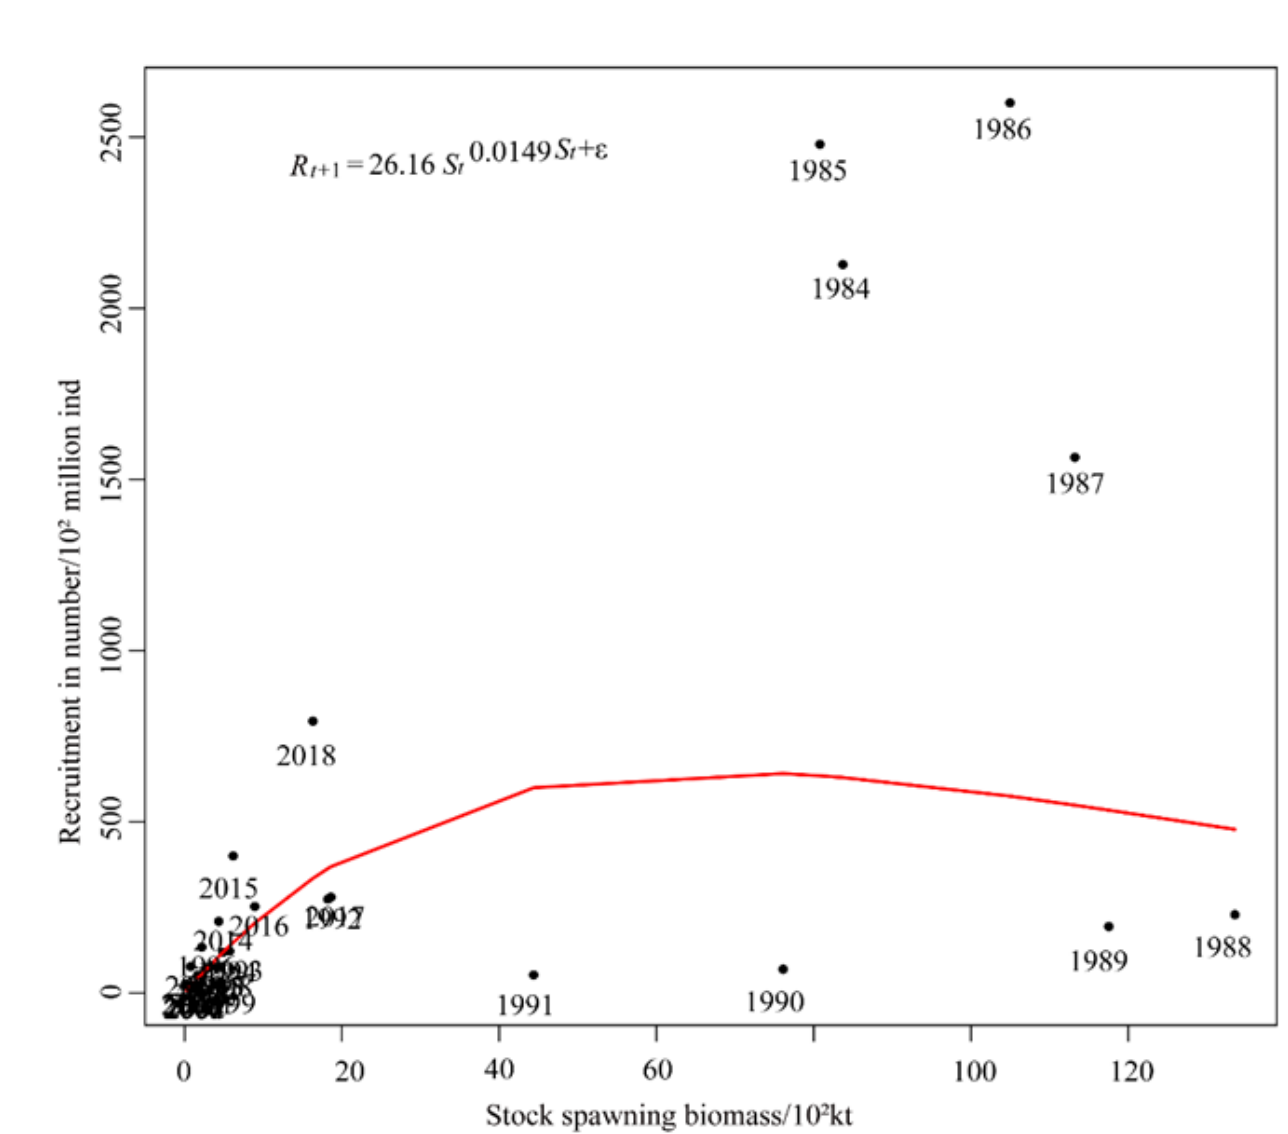
Figure 4. The relationship of S. melanostictus stock recruitment and the environment in 1984–2018.